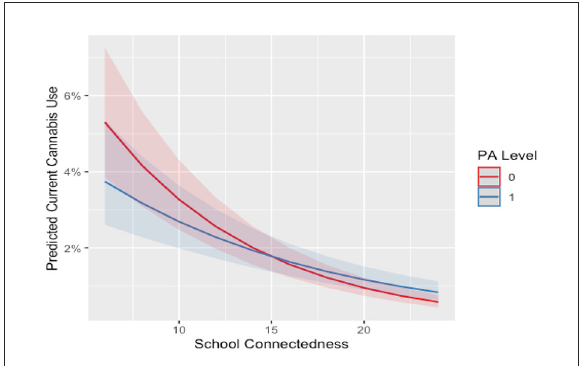
FIGURE4 Interaction between school connectedness and MVPA level on current cannabis use for females. 0, no, 1, yes.PA level, meeting moderate to vigorous physical activity level based on Canadian guidelines. Line and shade, mean and SE.